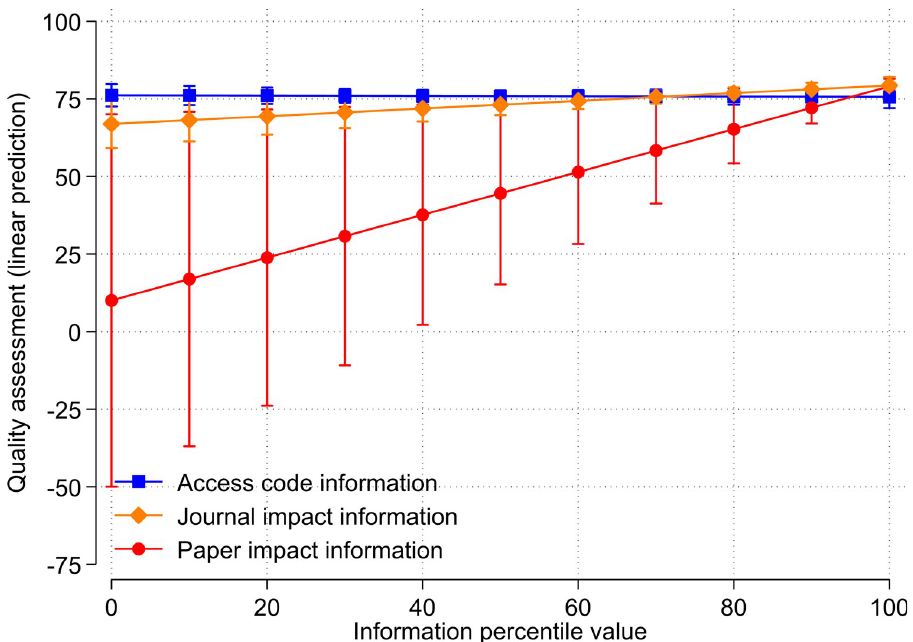
Fig 5. Relationship between treatments (access code information, journal impact information, and paper impact information) and quality assessments. Eighteen respondents with prior knowledge on our survey and/or Teplitksy, Duede (1) are excluded.